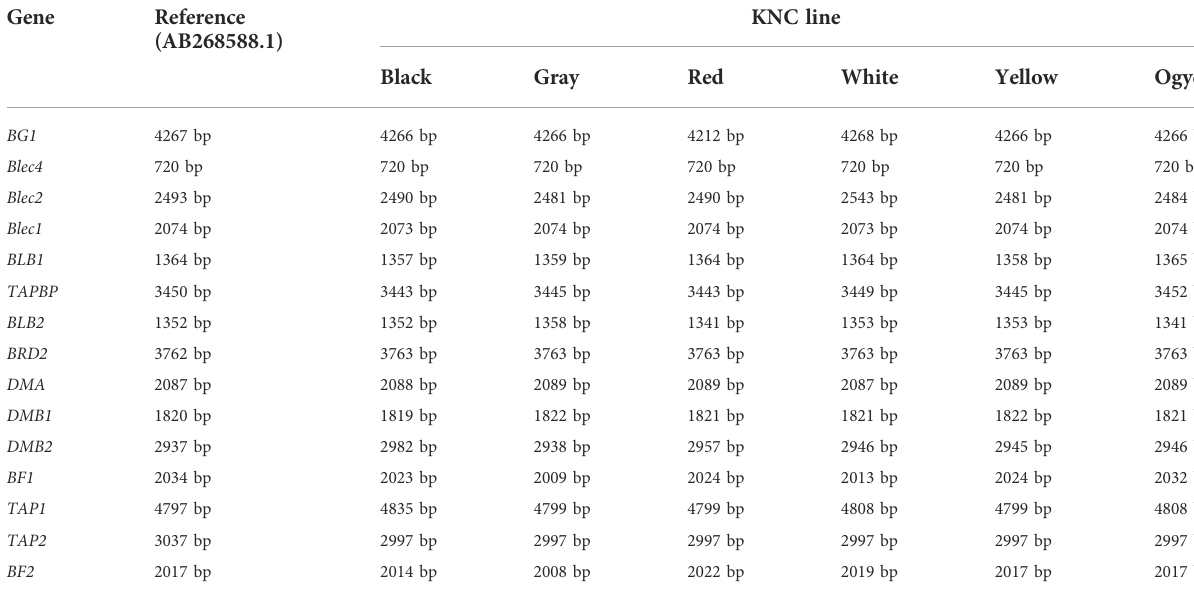
TABLE 2 Summary of the sizes of MHC- B genes (from BG1 - BF2 ) in KNC